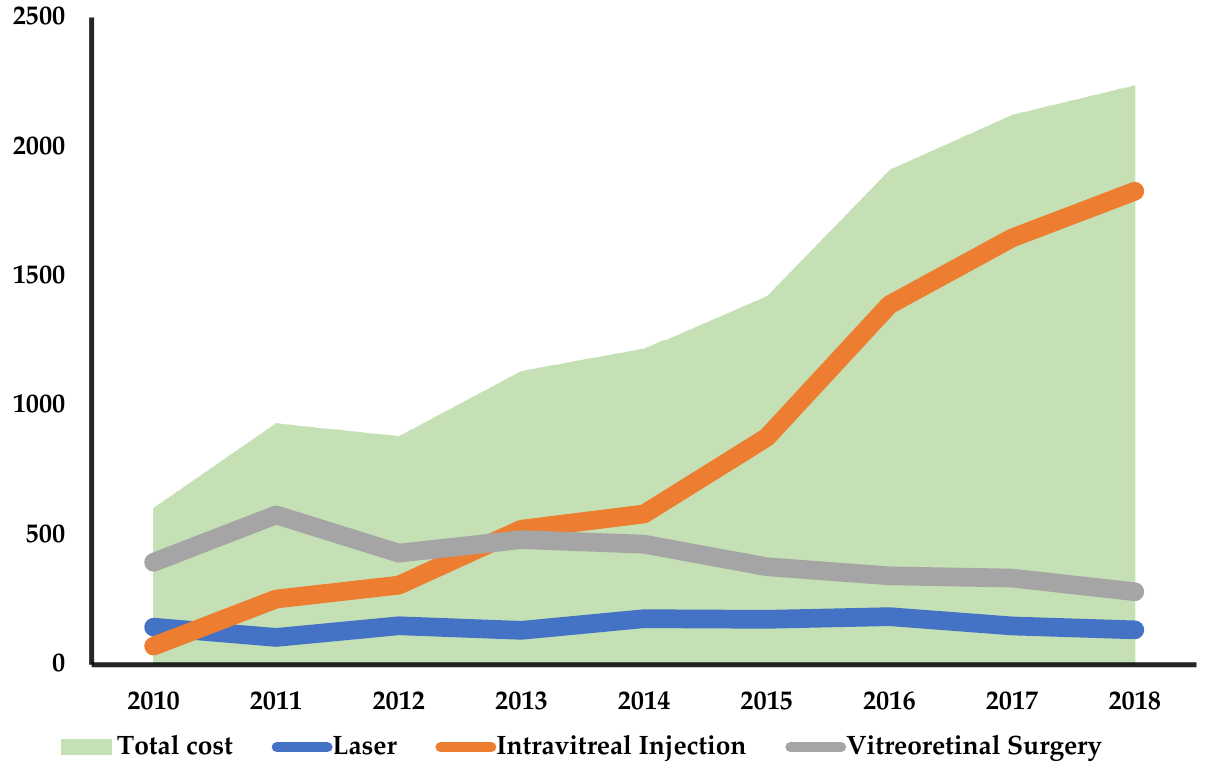
Figure 3. Annual total healthcare cost of treating diabetic retinopathy per modality and total treatment costs.